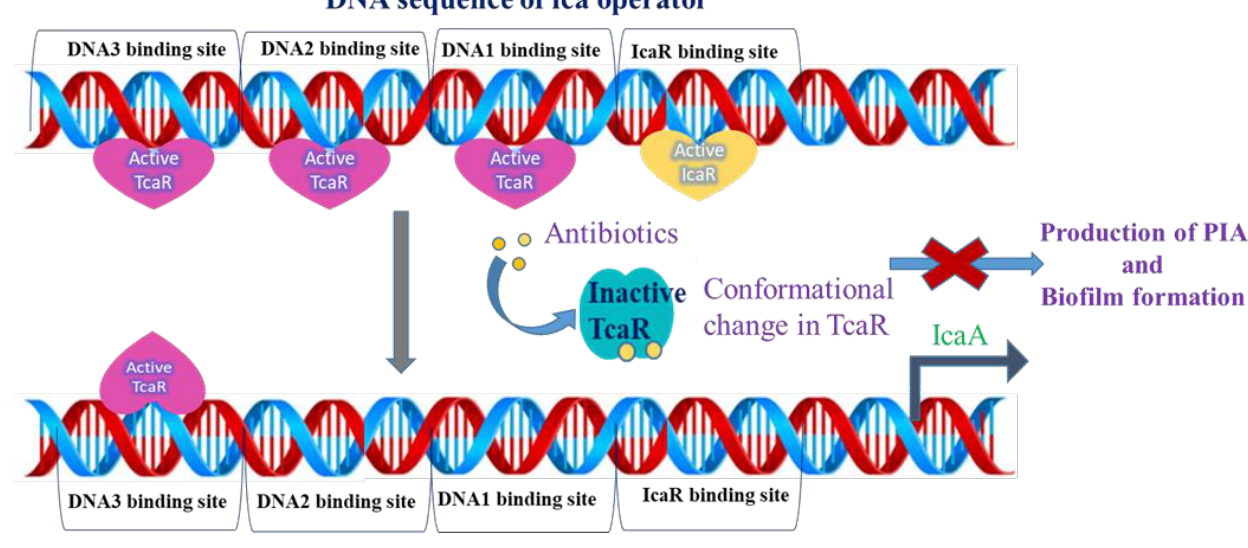
Figure 1. Illustration of antibiotic treatment of S. epidermidis TcaR preventing the formation of DNA- TcaR complex in ica operon, which leads to inhibition of biofilm formation. The active TcaR can interact with ica operator and prevents the transcription of IcaA . Upon treating with antibiotics, significant conformational changes in the DNA binding domain of TcaR will occur.